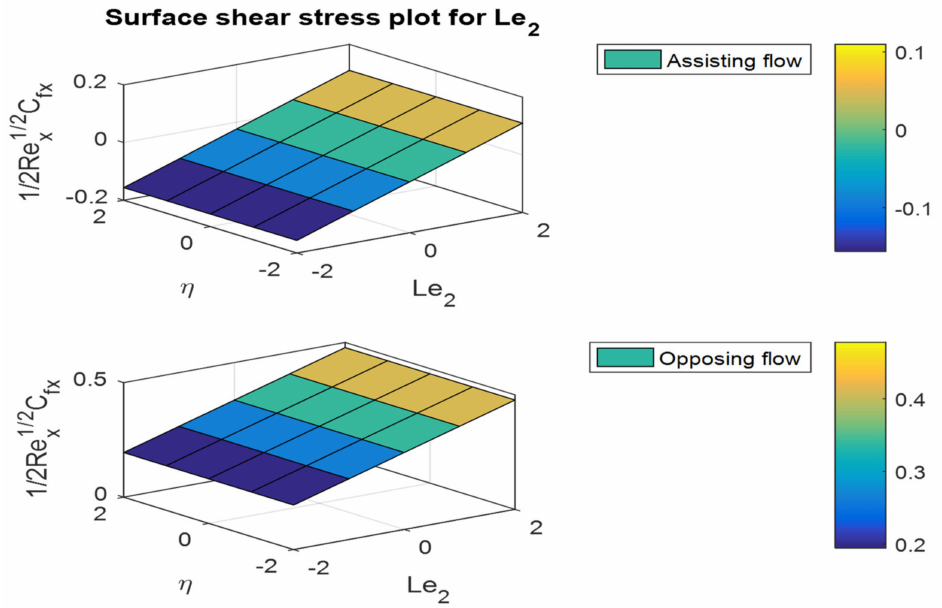
Figure 41. Surface plots for the f (cid:48)(cid:48) ( 0 ) for dissimilar values of Le 2